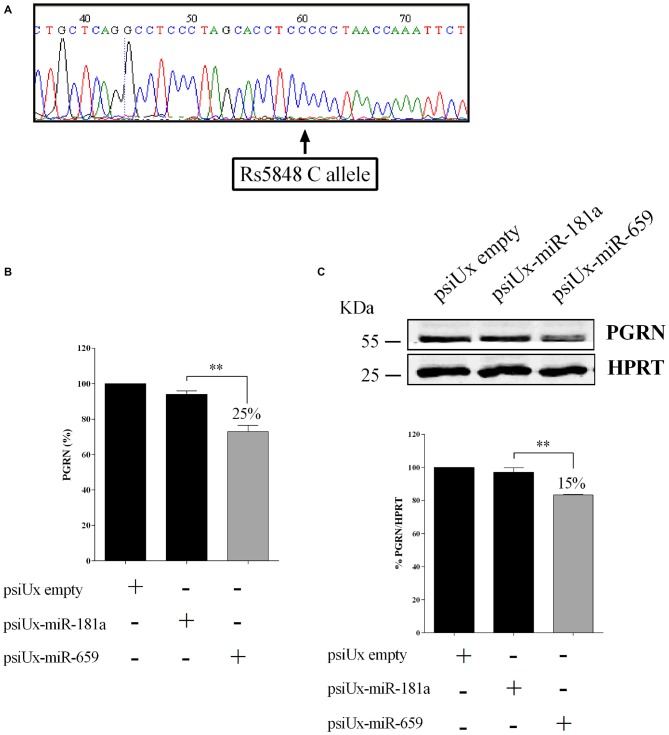
Functional interaction between progranulin (PGRN) expression levels and miR-659-3p in HeLa cells. HeLa 3′UTR sequencing showing a CC genotype (A). ELISA assay (B) for PGRN quantification in protein extracts from HeLa cells (N = 4; **p < 0.01). Western blot analysis (C) for PGRN detection in protein extracts from HeLa cells (N = 3; **p < 0.01). Western Blot image is representative of three biological replicates. Expression of Western Blot was normalized on HPRT expression.